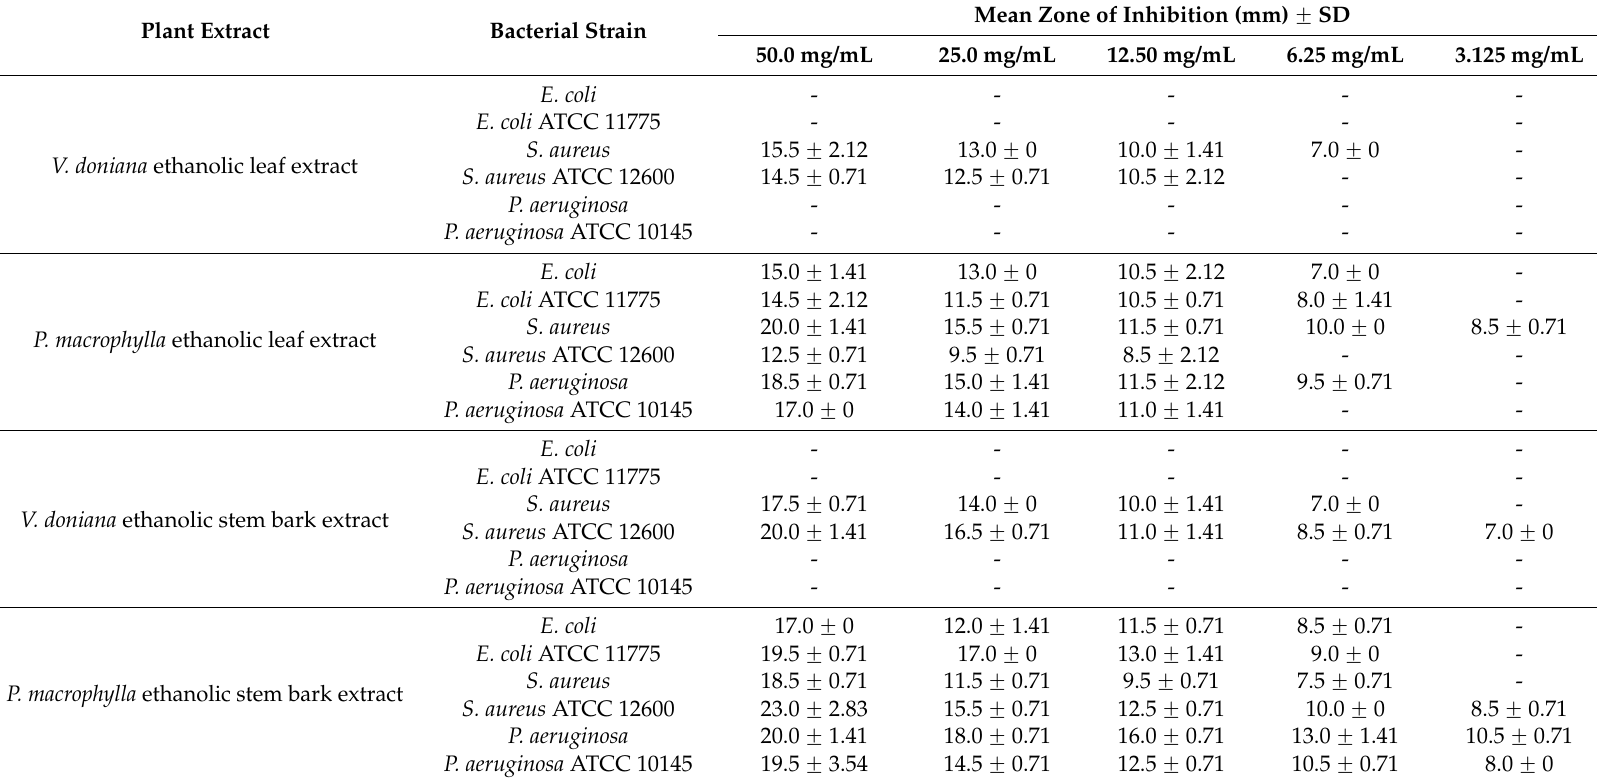
Table 2. Bacteria growth inhibition zones of ethanol extract of V. doniana and P. macrophylla